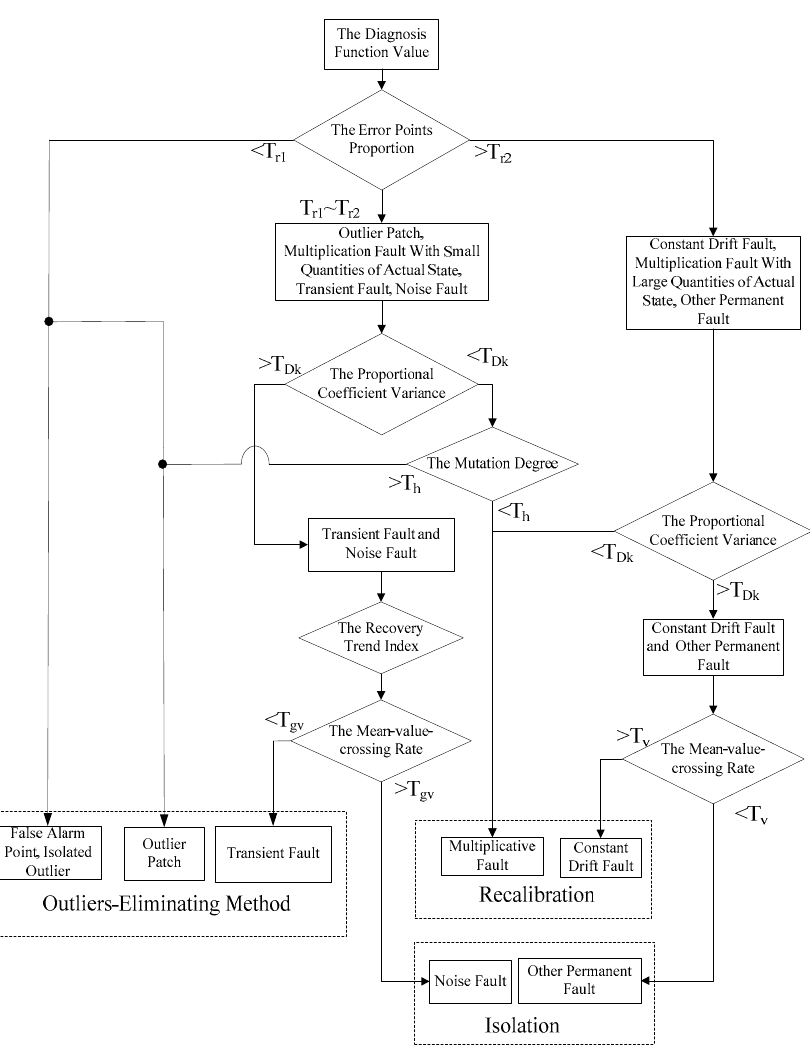
Figure 6. Logical order of data anomalies pattern recognition.